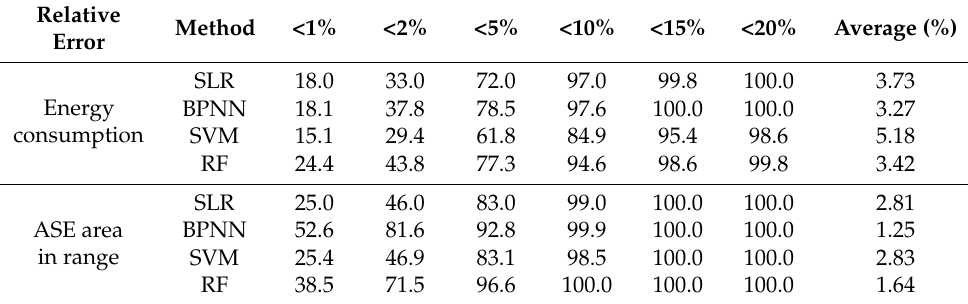
Table 6. Comparison of relative error.